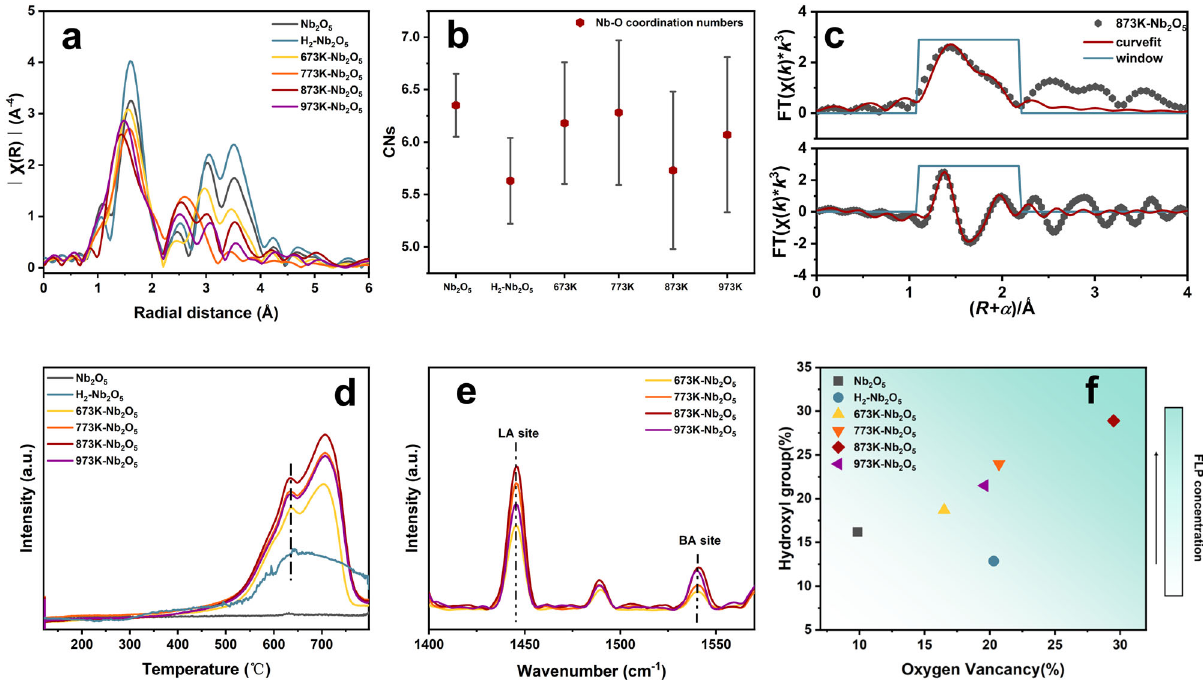
Fig. 3 | Analysis of FLP sites. a FT k 3 χ ( R )Nb K-edge EXAFS of different Nb 2 O 5 samples. b Fourier transformed EXAFS fi tting results of the Nb-O coordination numbers(CNs)fordifferentsamples.Errorbarsrepresentstandarddeviation. c Nb K-edge EXAFS (points) and curve fi t (line) for 873K-Nb 2 O 5 , shown in k 3 -weighted R -